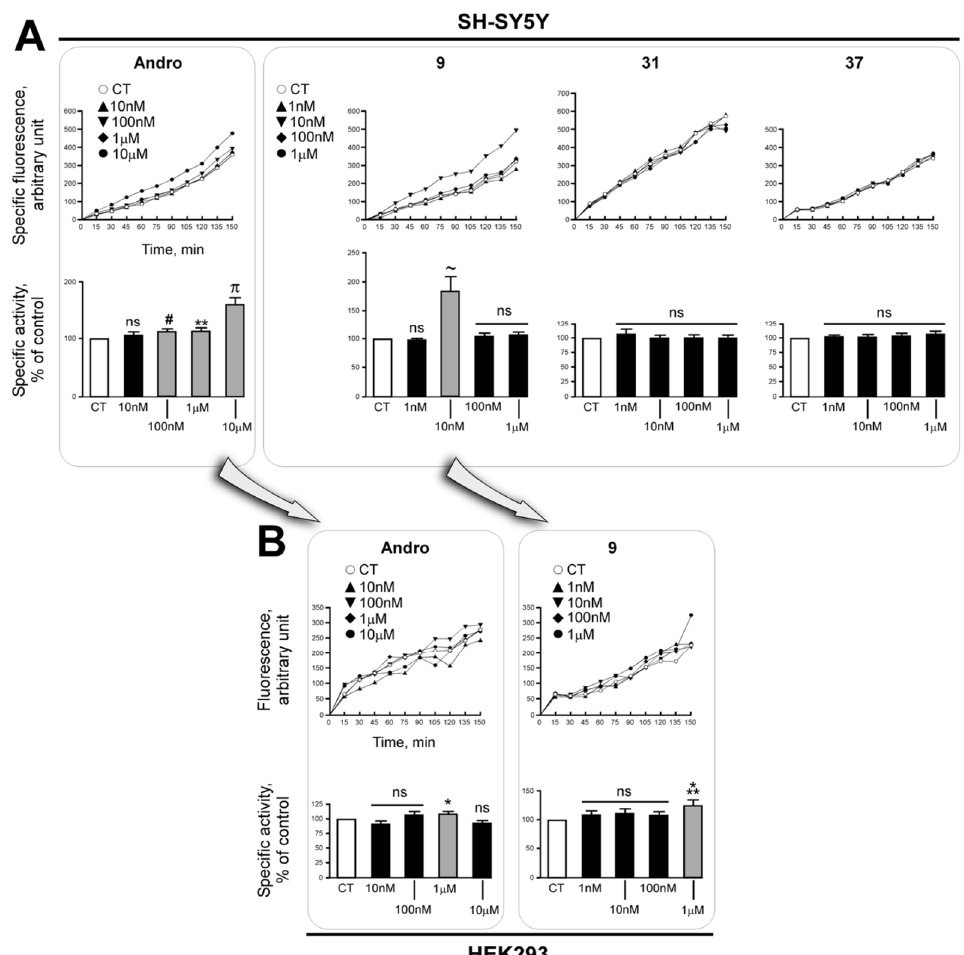
Figure 6. Effects of andrographolide and compounds 9 , 31 , and 37 on the α -secretase catalytic activity in human cells. ( A ) The α -secretase catalytic activity (phenanthroline-sensitive hydrolysis of the fluorimetric substrate JMV2770) was measured on cultured SH-SY5Y cells in the absence (control, white circle/white bar) or in the presence of various concentrations of the compounds (10 nM to 10 µ M for andrographolide; 1 nM to 1 µ M for compounds 9 , 31 , and 37 ). ( B ) Experiments carried out with andrographolide and 9 under the same conditions on cultured HEK293 cells. The curves represent the mean specific fluorescence (from 2 to 3 independent experiments including two controls each) while bars in histograms are expressed as a percentage of control (white bars, non-treated cells) calculated from the linear parts of the curves (initial velocity) and are the means ± SE of 8 to 16 independent determinations. * p < 0.05; ** p < 0.03; *** p < 0.02; # p < 0.01; ~ p < 0.003; π p < 0.0001 (gray bars); ns, no statistical difference (black